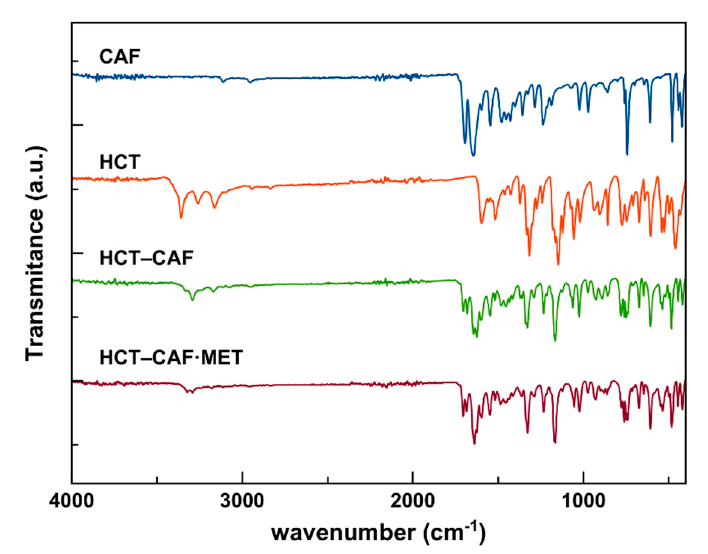
Figure 8. Comparison of Fourier transform infrared (FTIR) spectra of HCT, CAF, HCT–CAF and HCT–CAF · MET. Table 2. Summary of relevant FTIR vibrational frequencies (cm − 1 ) in the spectra of HCT, CAF, HCT–CAF and HCT–CAF · MET.